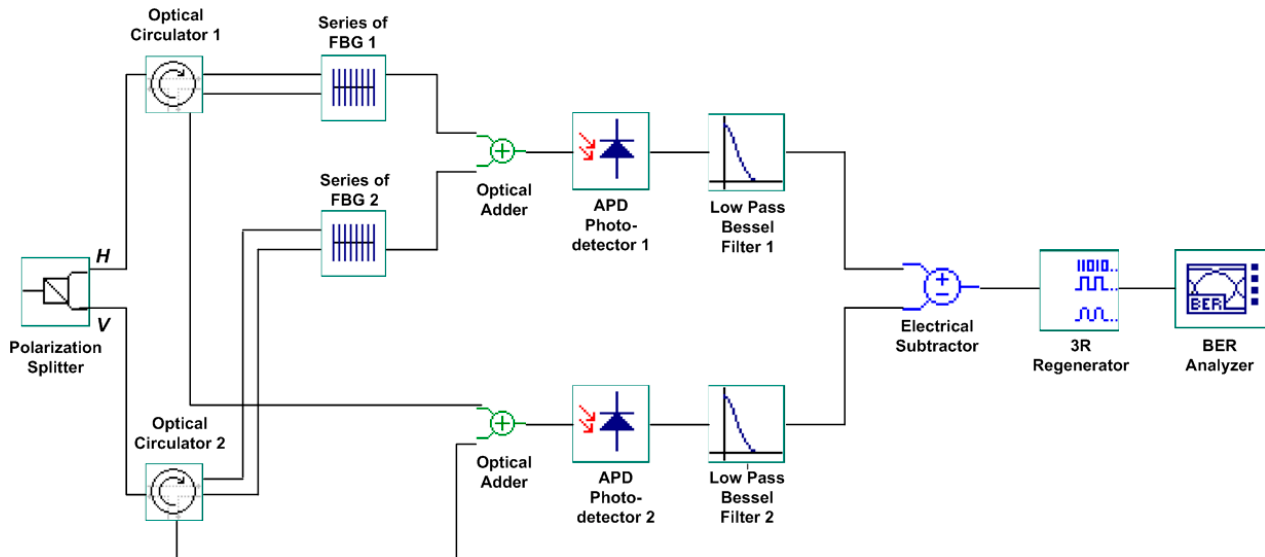
Figure 2. Proposed Bi ‐ OCDMA decoder.